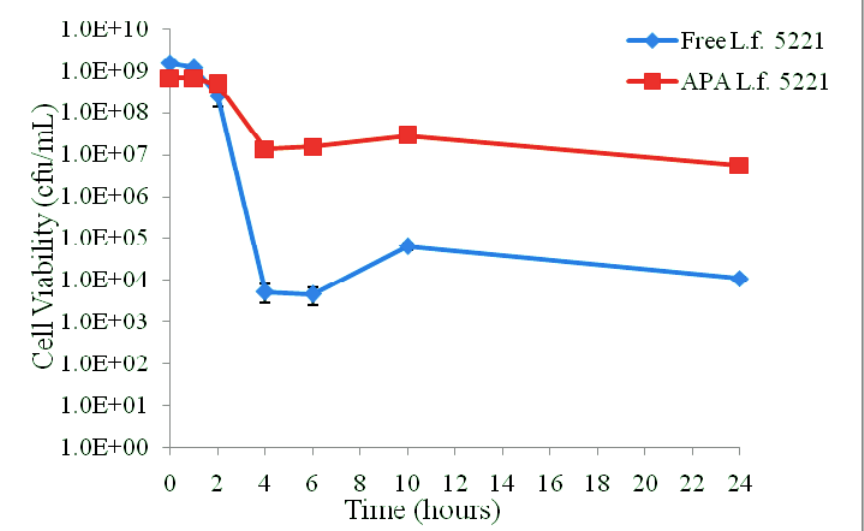
Figure 5 . The viability of L. fermentum NCIMB 5221 in free and encapsulated form was determined upon exposure to the simulated GI conditions using standard colony counting methods. Each point represents the mean of triplicates and the error bars the standard deviations. A significant difference in viability between free and microencapsulated bacterial cells following simulated GI exposure was observed ( p < 0.001; Tukey’s HSD).